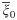
The average fractions of receptors in different methylation levels (a) ξ¯0 (b) ξ¯2 (c) ξ¯1 at low ligand concentrations, and (d) ξ¯1 at high ligand concentrations, as a function of an internal enzyme concentration (R0), for fixed substrate concentration A0 = 13.6μM.